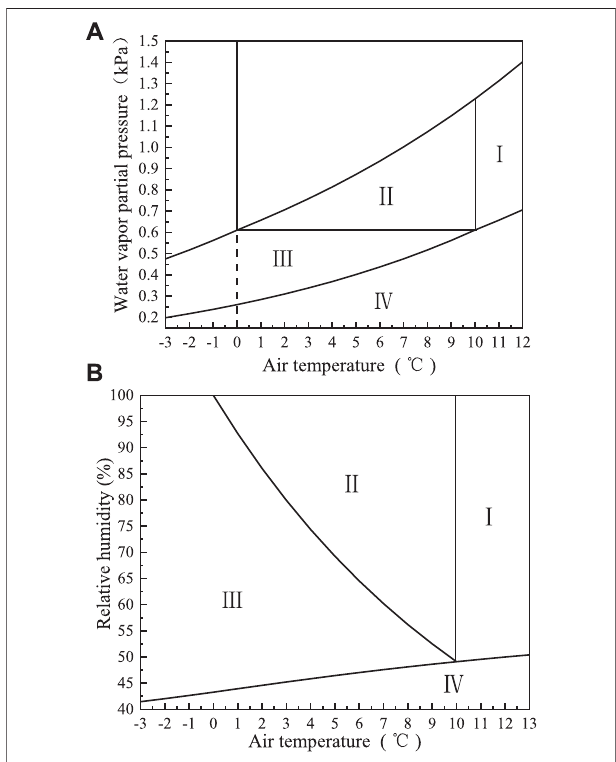
FIGURE 2 | Conversion of the frosting types between the three-phase diagram of water and temperature – humidity diagram: (A) the frosting types divided in the three-phase diagram of water; (B) the frosting types divided in the temperature – humidity diagram.